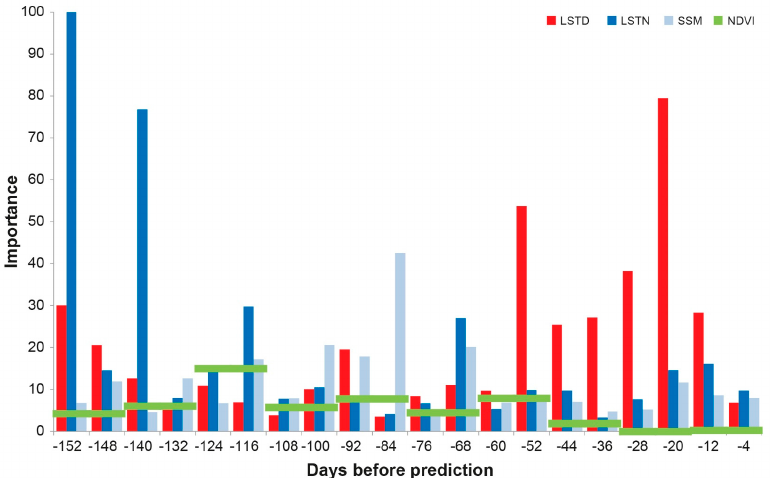
Figure 7. Overall importance of the 70 lagged variables. The values reported on the x -axis represent the days before